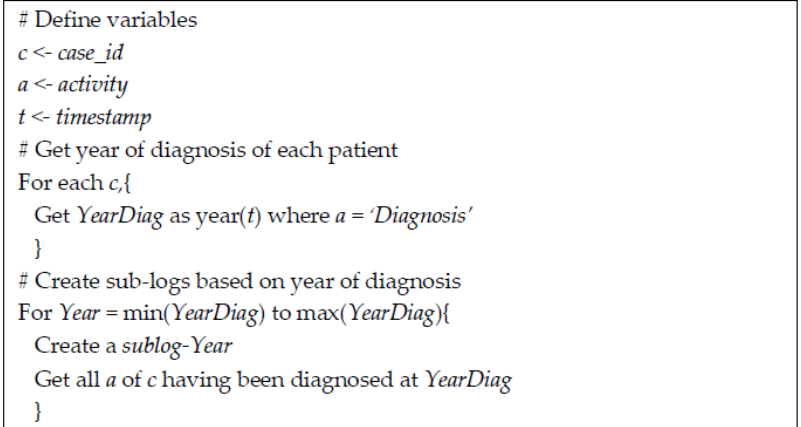
Figure 2. The algorithm of sub-log creation.